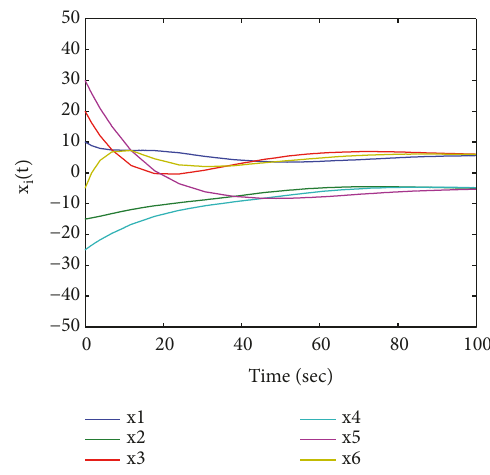
Figure 2: State trajectories of six agents.